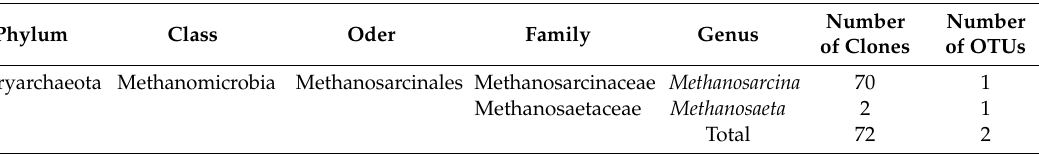
Table 2. List of archaeal